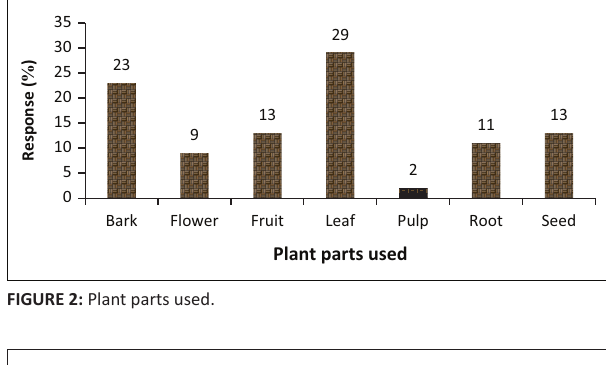
FIGURE 2: Plant parts used.